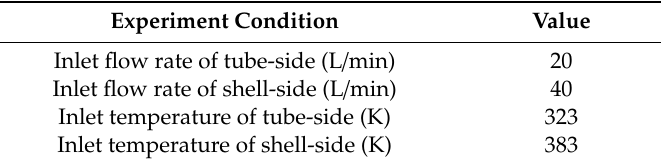
Table 2. Experiment conditions for STHX-DDB and STHX-SB.